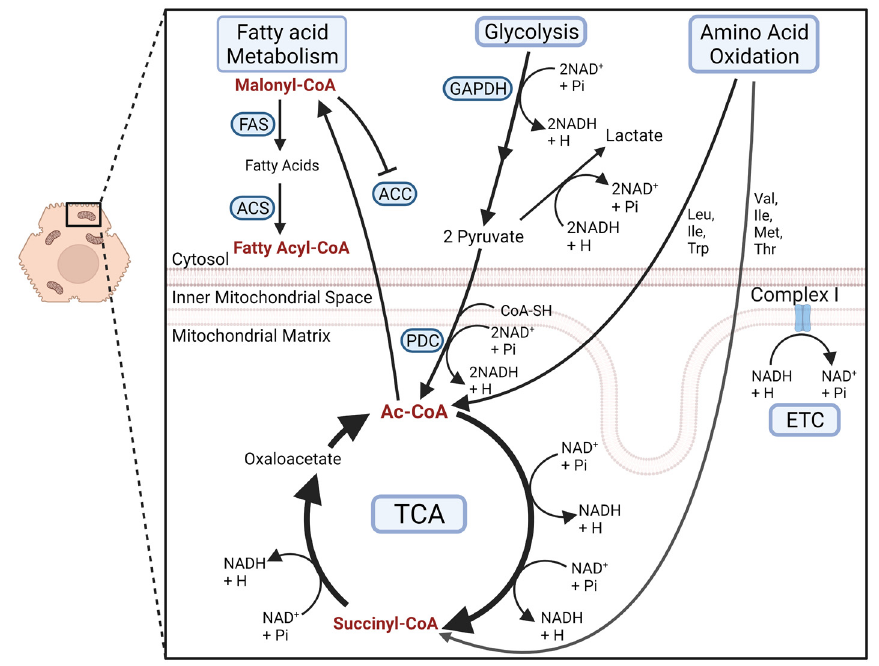
Figure 2. Reactive acyl groups are generated through the citric acid cycle (TCA), fatty acid metabolism, glycolysis, and amino acid oxidation. Additionally, nicotinamide adenine dinucleotide (NAD + /NADH) redox ratios are controlled by different metabolic processes as electron shuttling molecules. Abbreviations: ACC, acetyl-CoA carboxylase; Ac-CoA, acetyl-CoA; ACS, acyl-CoA syn- thase; ETC, electron transport chain; FAS, fatty acid synthase; GAPDH, glyceraldehyde 3-phosphate dehydrogenase; Ile, isoleucine; H, hydrogen; Leu, leucine; Met, methionine; NADH, nicotinamide adenine dinucleotide; PDC, pyruvate dehydrogenase complex; Pi, phosphate group; TCA, citric acid cycle; Thr, threonine; Trp, tryptophan; Val, valine.